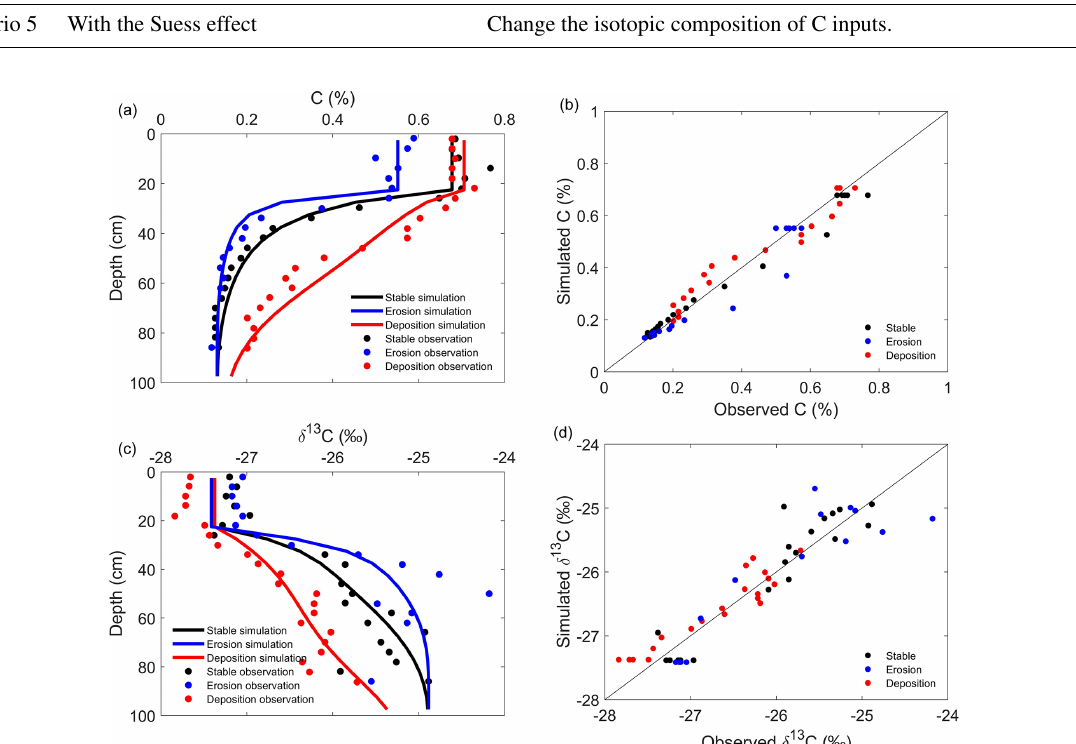
Figure 2. Observed and simulated C content and δ 13 C values of stable, erosion and depositional areas at the Belgian study site. Observed and simulated C contents in the format of profiles (a) and 1:1 lines (b) ; observed and simulated δ 13 C values in the format of profiles (c) and 1:1 lines (d)